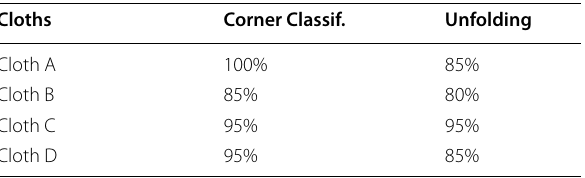
The middle column shows the success ratio in edge classification, and the right column the success ratio in grasping and unfolding